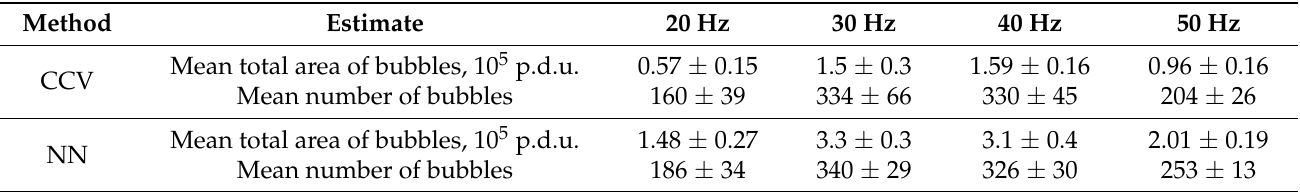
Table 2. Selected quantitative estimates of the applied methods: the metrics were considered due to their direct correspondence to project goals. One should note that the absolute values should be calibrated; thus, the standard deviations are more